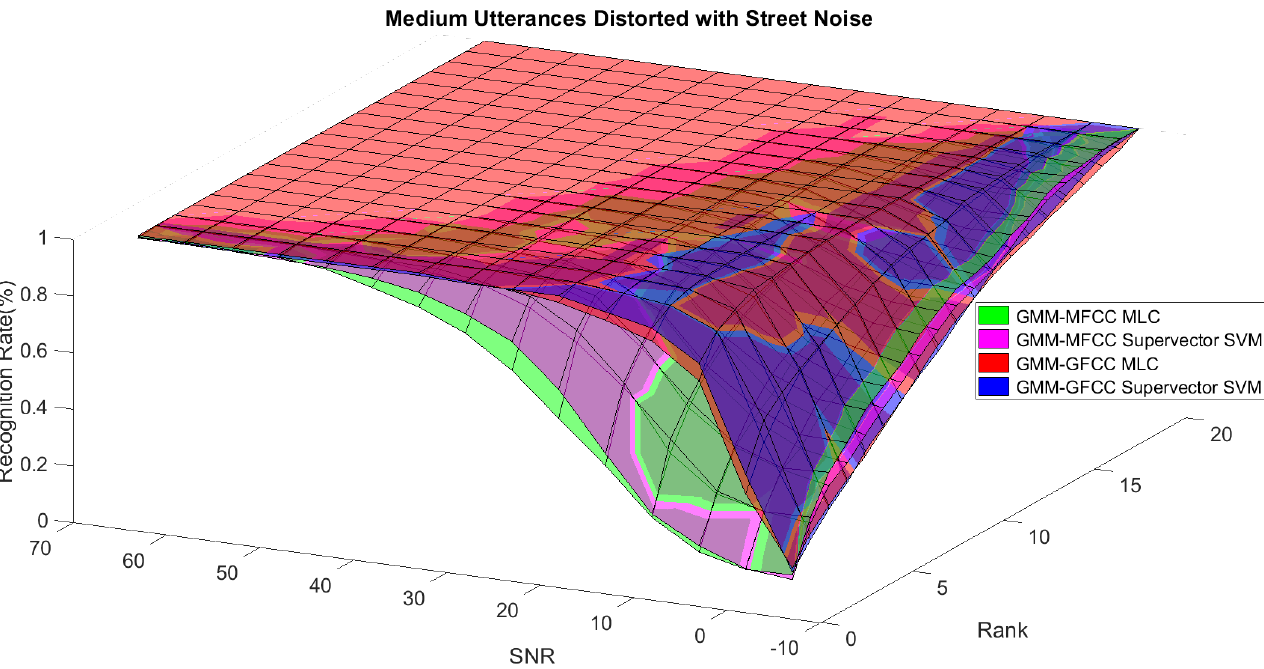
Figure 16. The 3D surface of the recognition rates for the base classifiers on short utterances distorted with street noise.